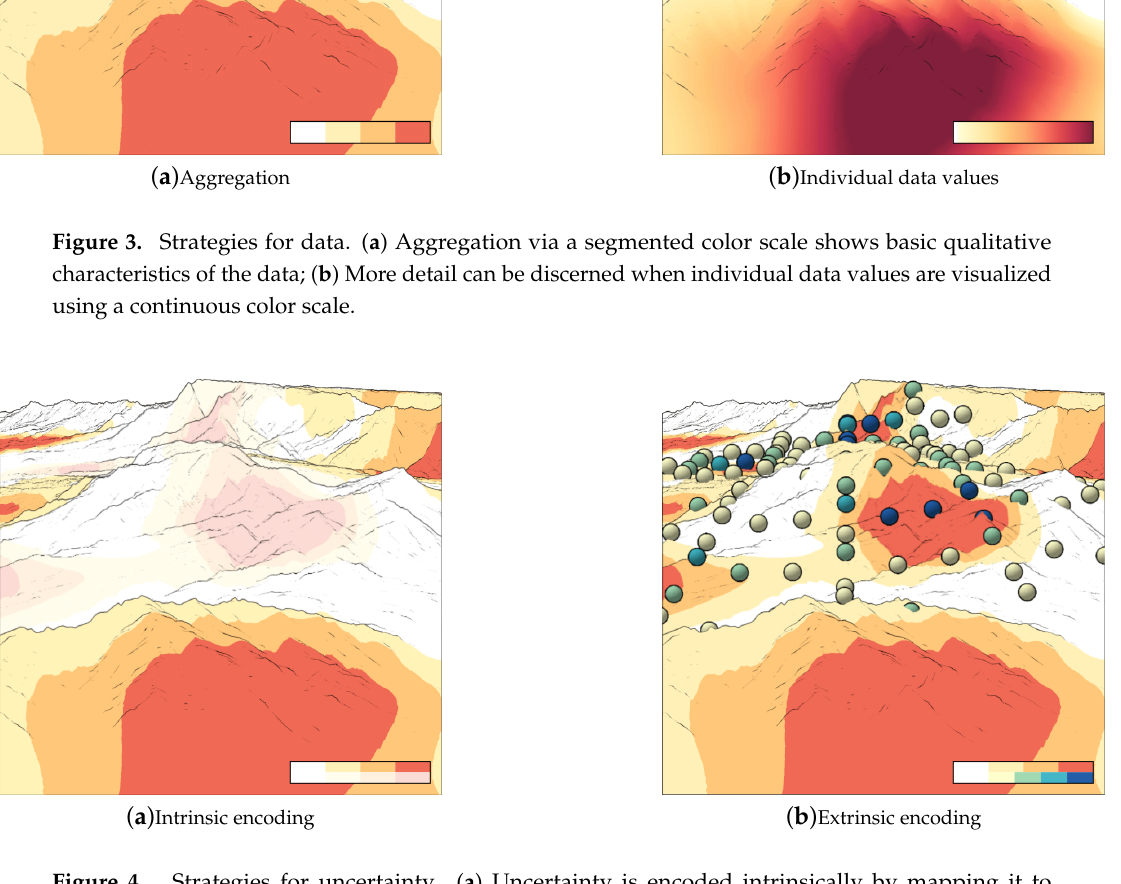
Figure 4. Strategies for uncertainty. ( a ) Uncertainty is encoded intrinsically by mapping it to transparency; ( b ) Uncertainty is encoded extrinsically by mapping it to the color of additional circles embedded into the terrain.